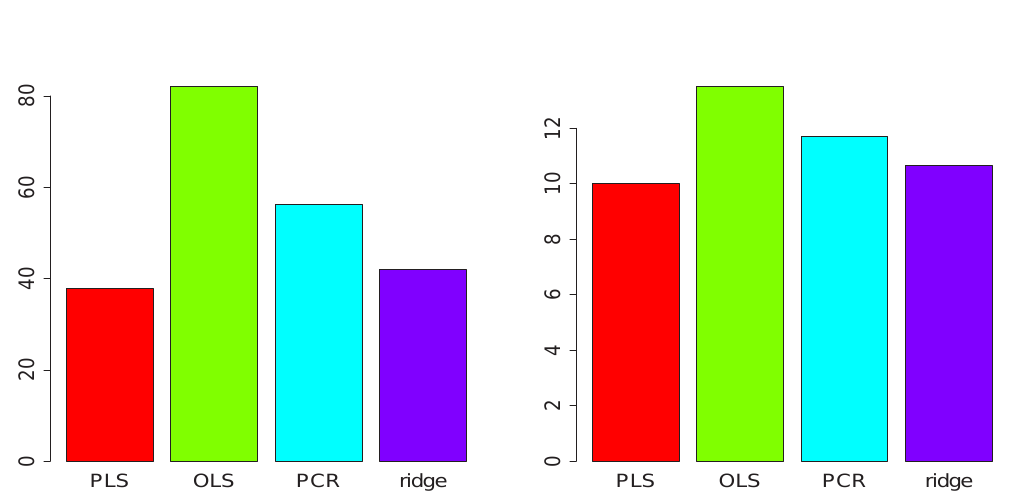
Figure 2: Overall performance of the regression methods: Sum of the squared differences be- tween the true and the predicted correlation: for the original correlation structure (left), and for destroyed correlations